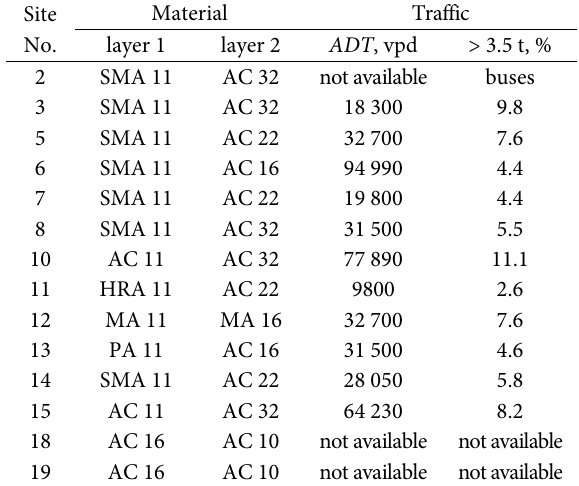
Table 3. Remaining road pavements in 2006 and traffic